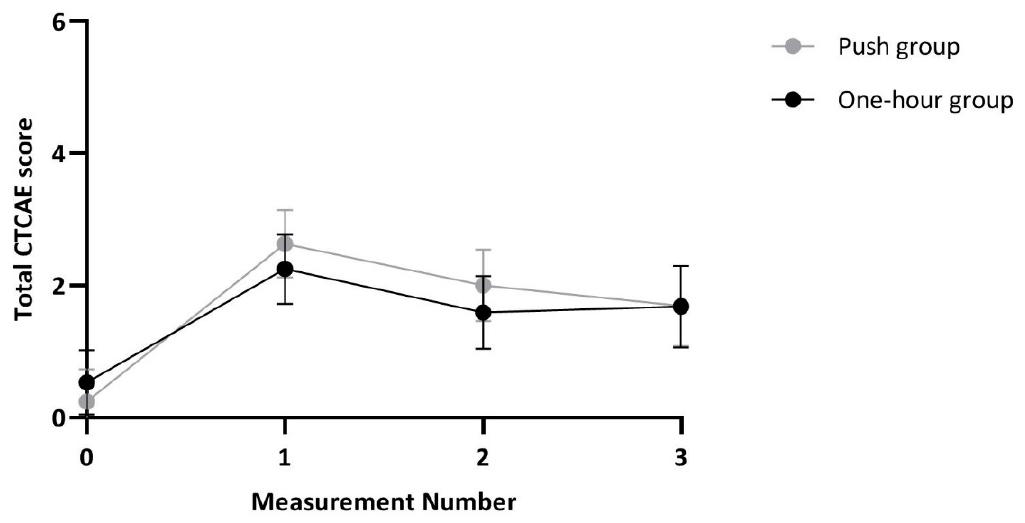
Figure 2. Total Common Terminology Criteria of Adverse Events score per administration